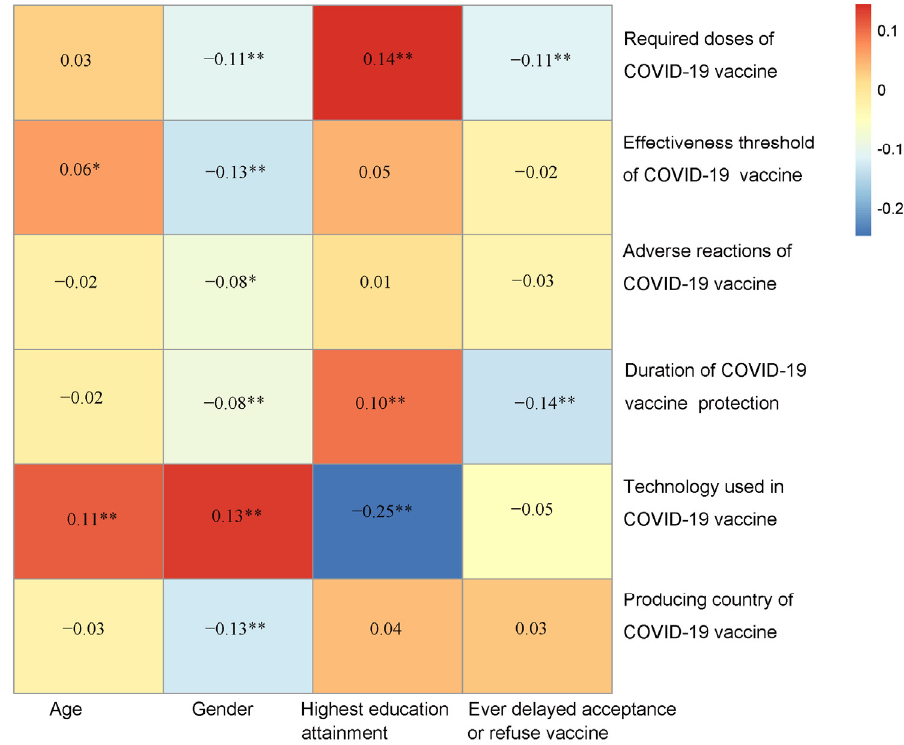
Figure 3. The correlations between demographic characteristics and vaccine characteristics influencing vaccination attitudes of all participants in Japan. * p < 0.05, ** p < 0.01.